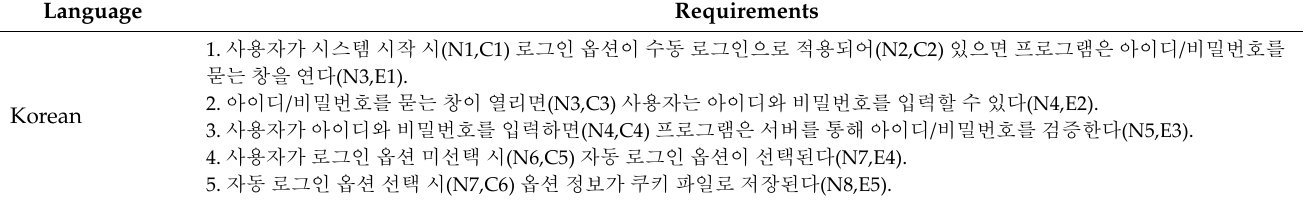
Table 5. The Korean Requirements List.